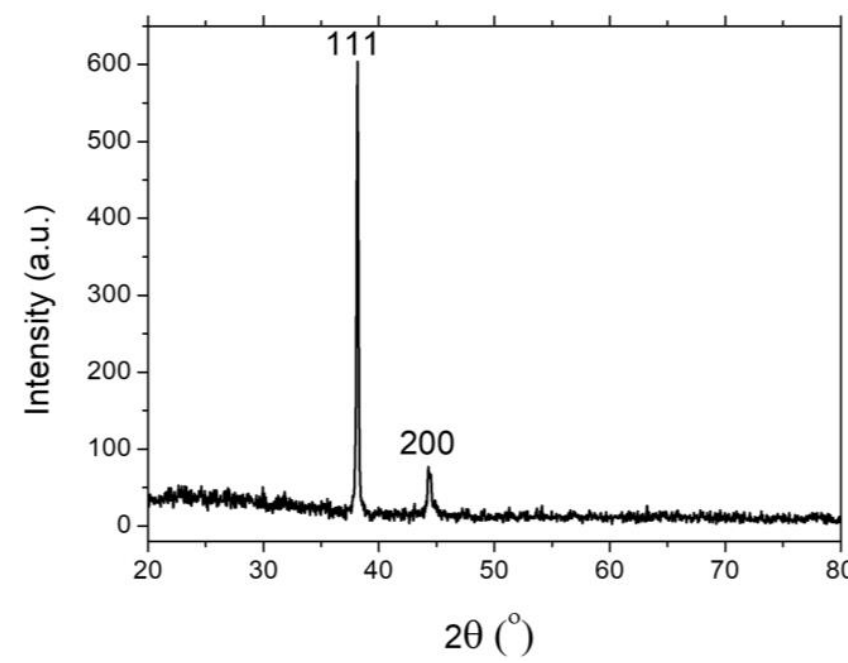
Figure 4. The UV-Visible spectrum of the silver nanowires that were suspended in ethanol and synthesized utilizing the salt mediator polyol method.